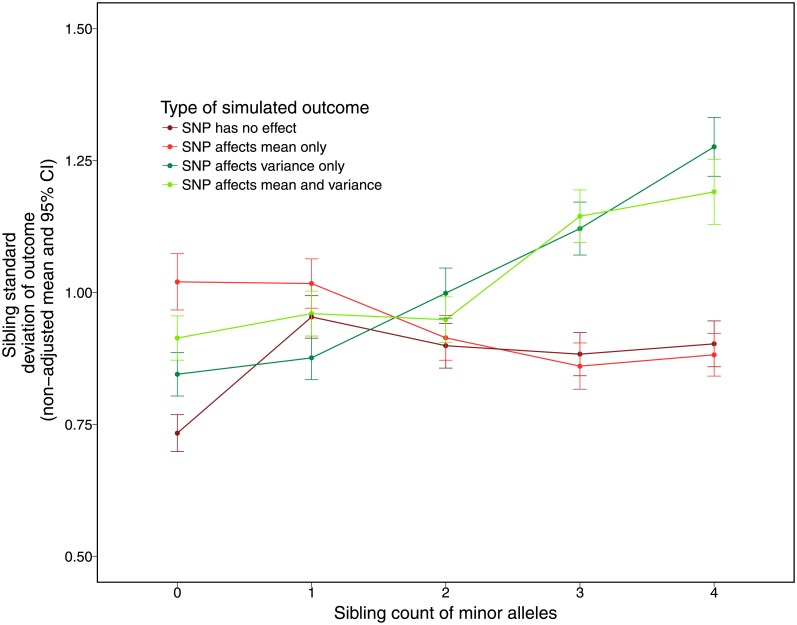
Raw means of sibling standard deviations (before age, sex, mean of trait, and parental genotype controls) by count of minor alleles.The graph shows that the sibling standard deviation increases with the count of minor allele snps that have effects on variance only, or effects on both the mean and variance of a trait, while stays flat for snp’s that only effect the mean or that not associated with the trait.